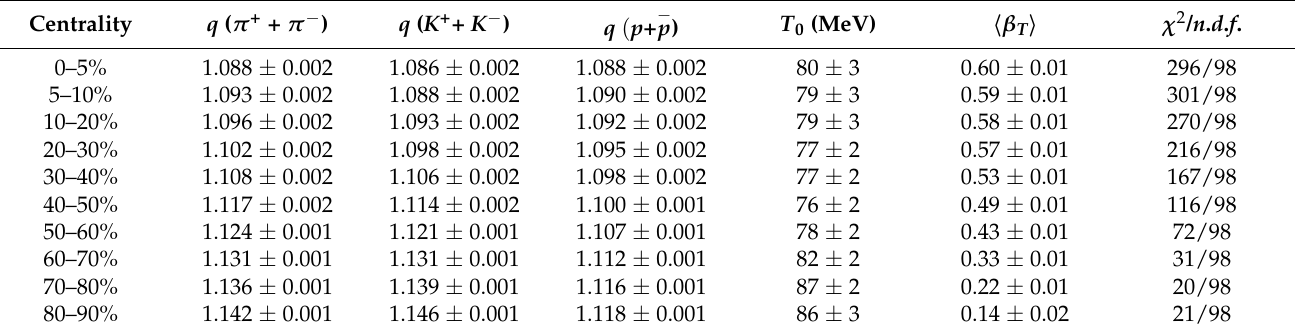
Table 2. The results of combined minimum χ 2 fits with thermodynamically consistent Tsallis function with transverse flow (Equation (5)) of p T spectra of particles in Pb + Pb collisions at n.d.f. denotes the number of degrees of freedom.